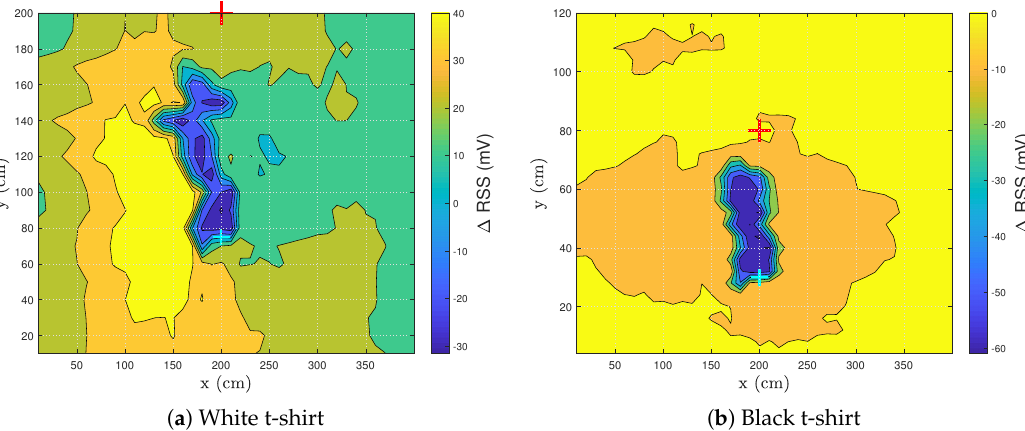
Figure 10. RSS distribution for layout 3. The red cross represents the LED, while the cyan cross denotes the PD. The PD is fixed at location